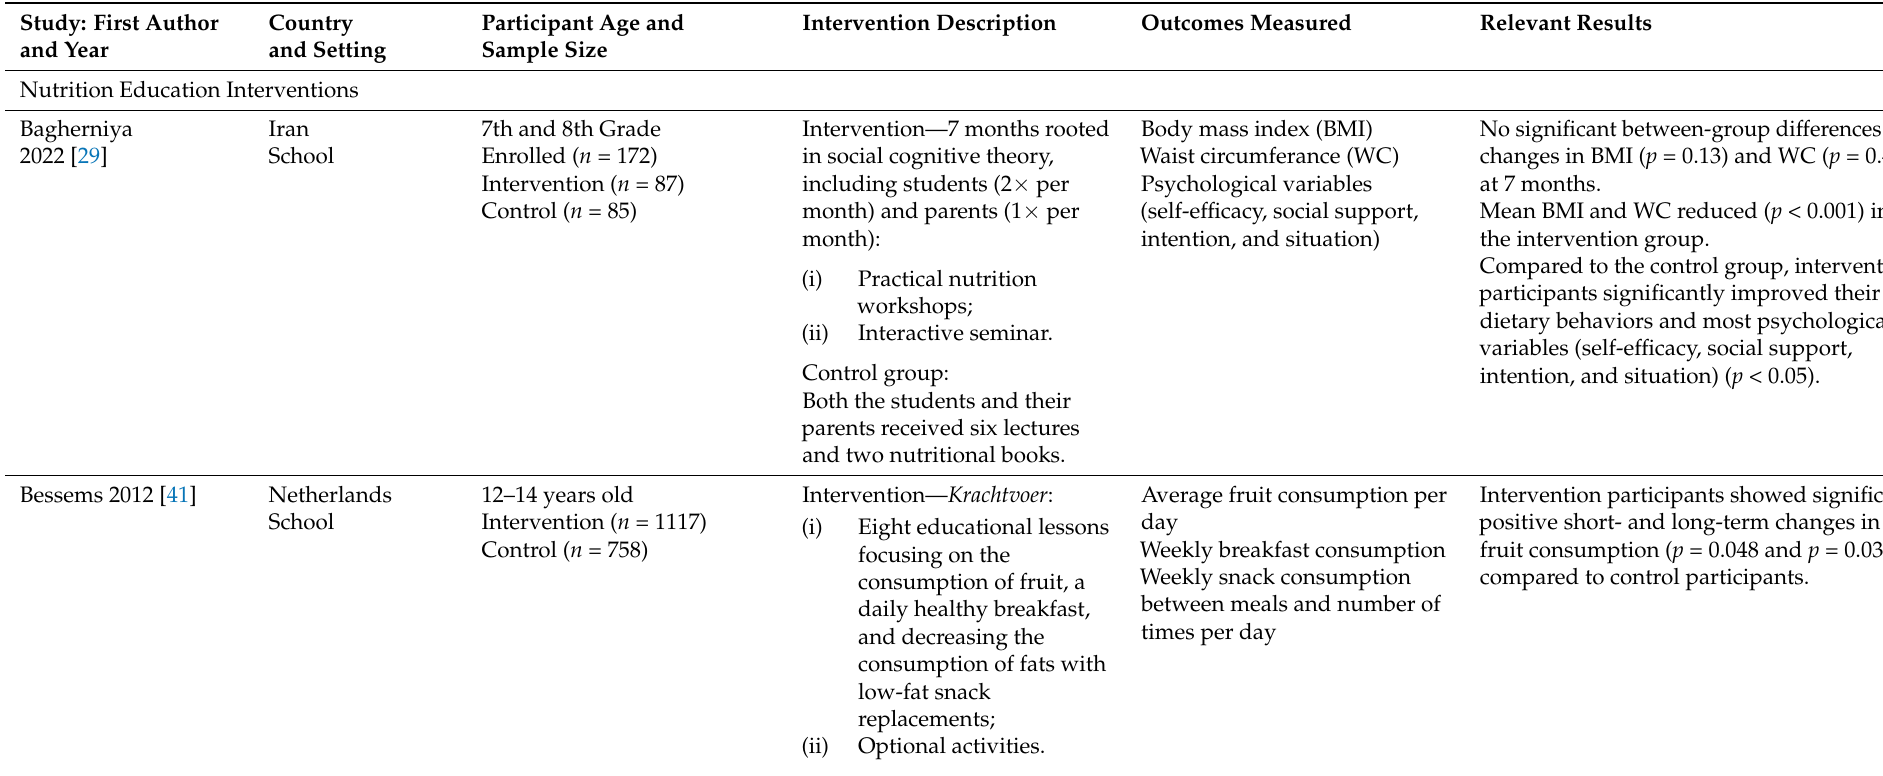
Table 1. Characteristics of included